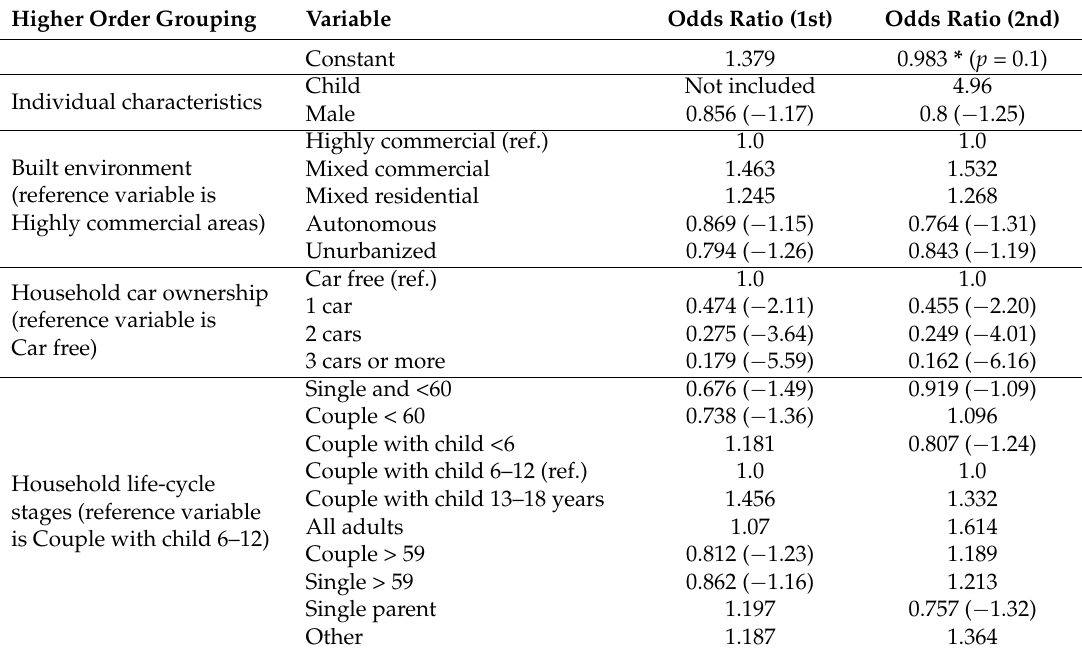
Table 4. Binary logistic regression results for the active travel portion of a trip being equivalent